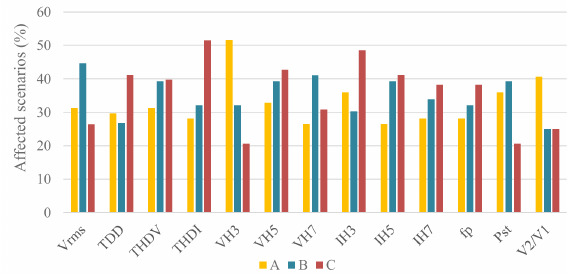
Figure 26. Percentage of a ff ected scenarios per parameter in each phase. Adapted from